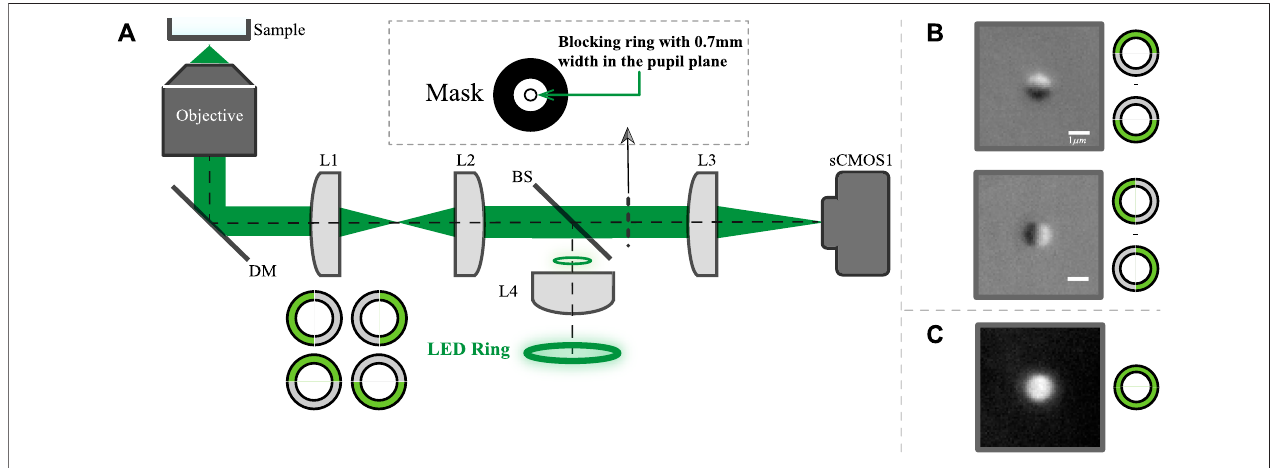
FIGURE1| Theproposedimagingsystemlayoutandexemplaryimages. (A) Schematiclayoutoftheproposedsystemwhereboththeilluminationanddetectionis on one side of the objective. (B) images of 1 μ m bead with vertically or horizontally asymmetrical illumination; (C) Symmetric illumination dark fi eld image of the same